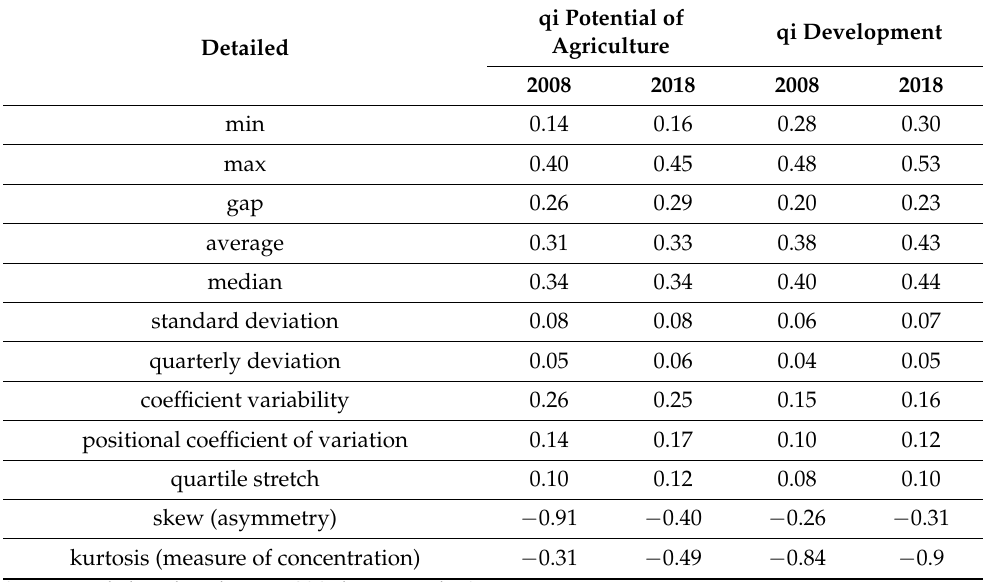
Table 5. Statistical characteristics of the synthetic measure of development and agricultural potential of voivodships in Poland in 2008 and 2018. qi Potential of qi Development Agriculture Detailed 2008 2018 2008 2018 min 0.14 0.16 0.28 0.30 max 0.40 0.45 0.48 0.53 gap 0.26 0.29 0.20 0.23 average 0.31 standard deviation quarterly deviation 0.05 coefficient variability 0.26 0.25 0.15 0.16 positional coefficient of variation 0.14 quartile